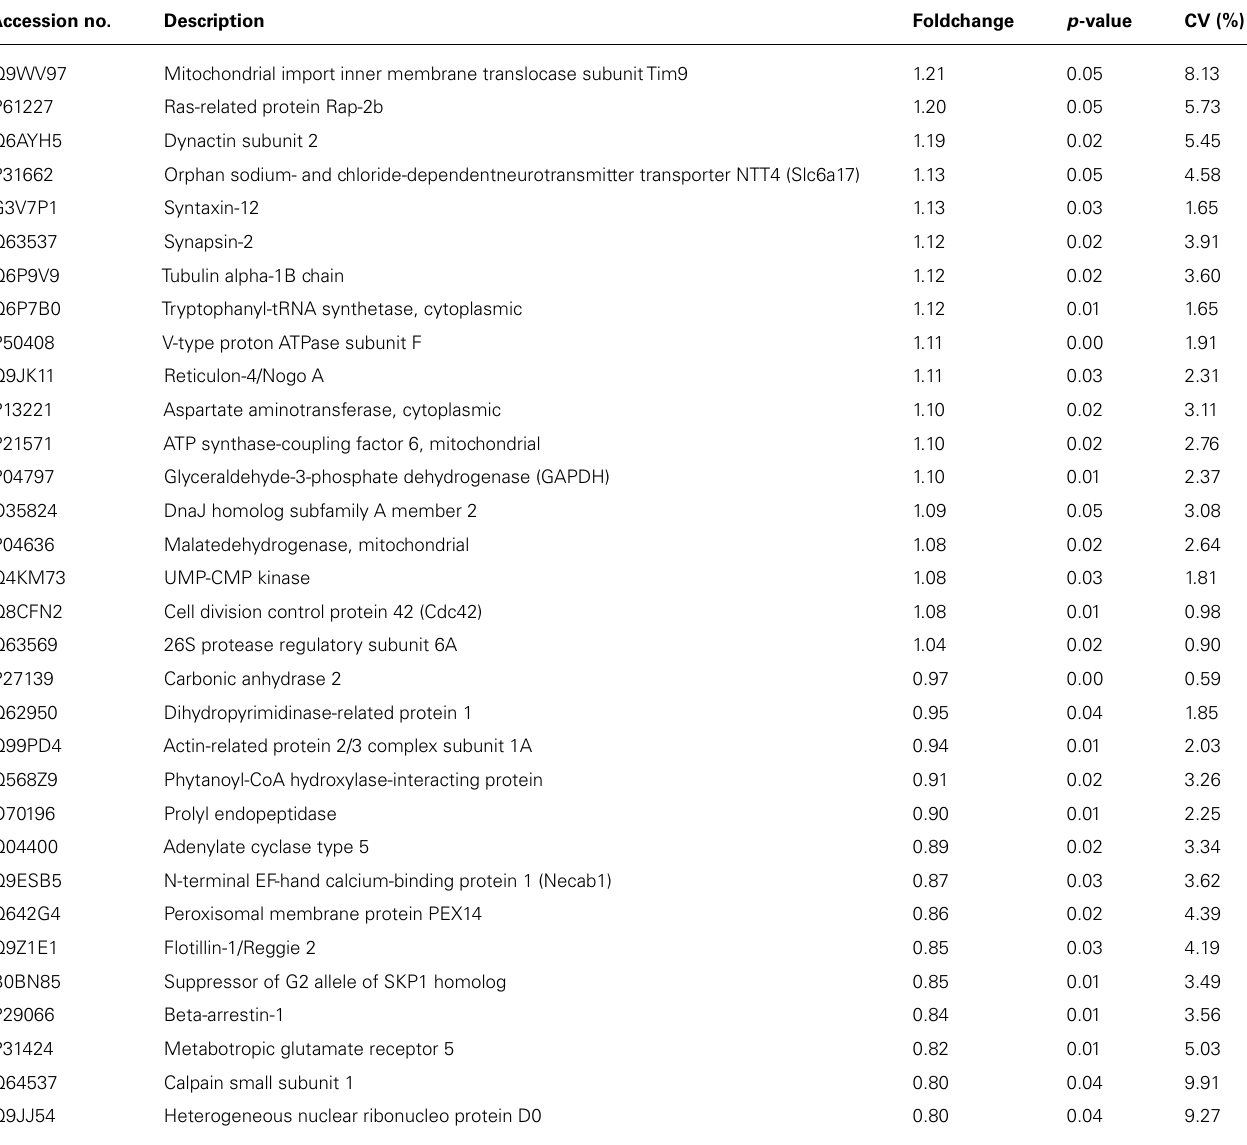
Table 1 | Proteins with altered expression level after radixin inhibition in the SVZ as detected by isobaric labeling and mass spectrometry. Accession